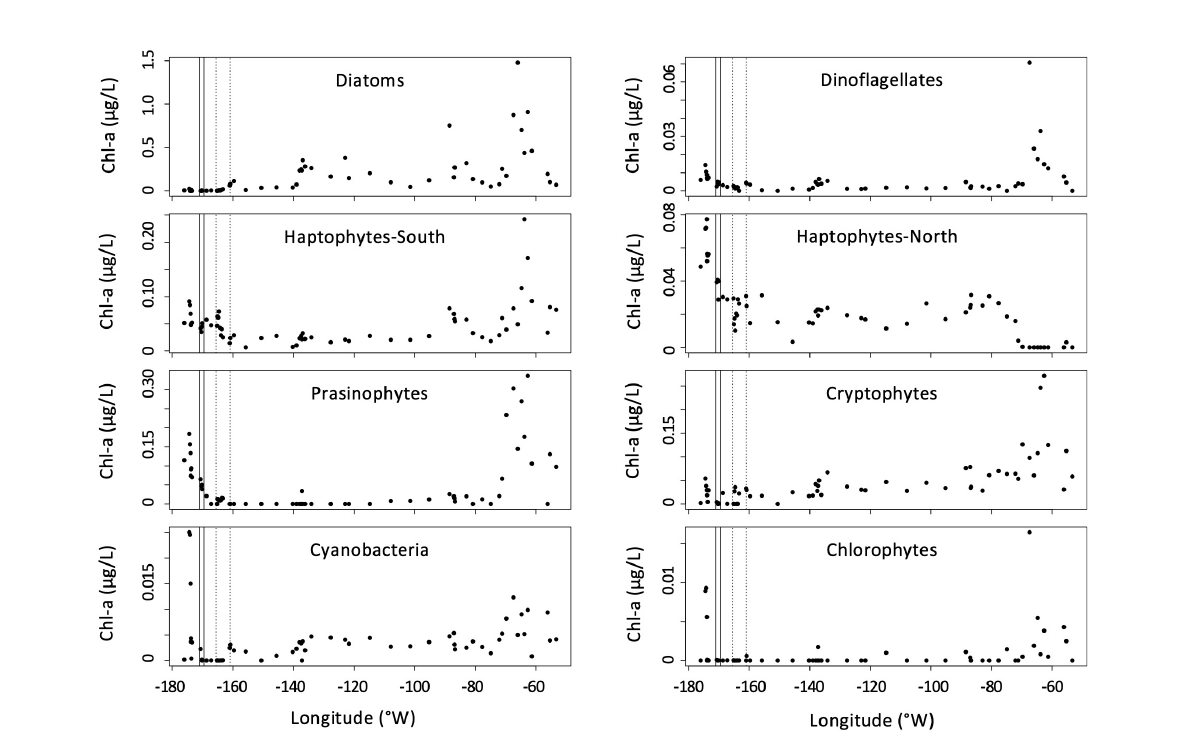
FIGURE 3 CHEMTAX estimates of phytoplankton pigment groups to total chl-a concentrations ( m g/L) during the ANA08D 2018 research expedition. The boundaries of the SAF and PF are indicated by solid and dotted vertical lines,